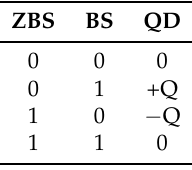
Table 2. Truth table of a bit-stream (BS) minus the ZBS resulting in the quanta decoded value (QD).